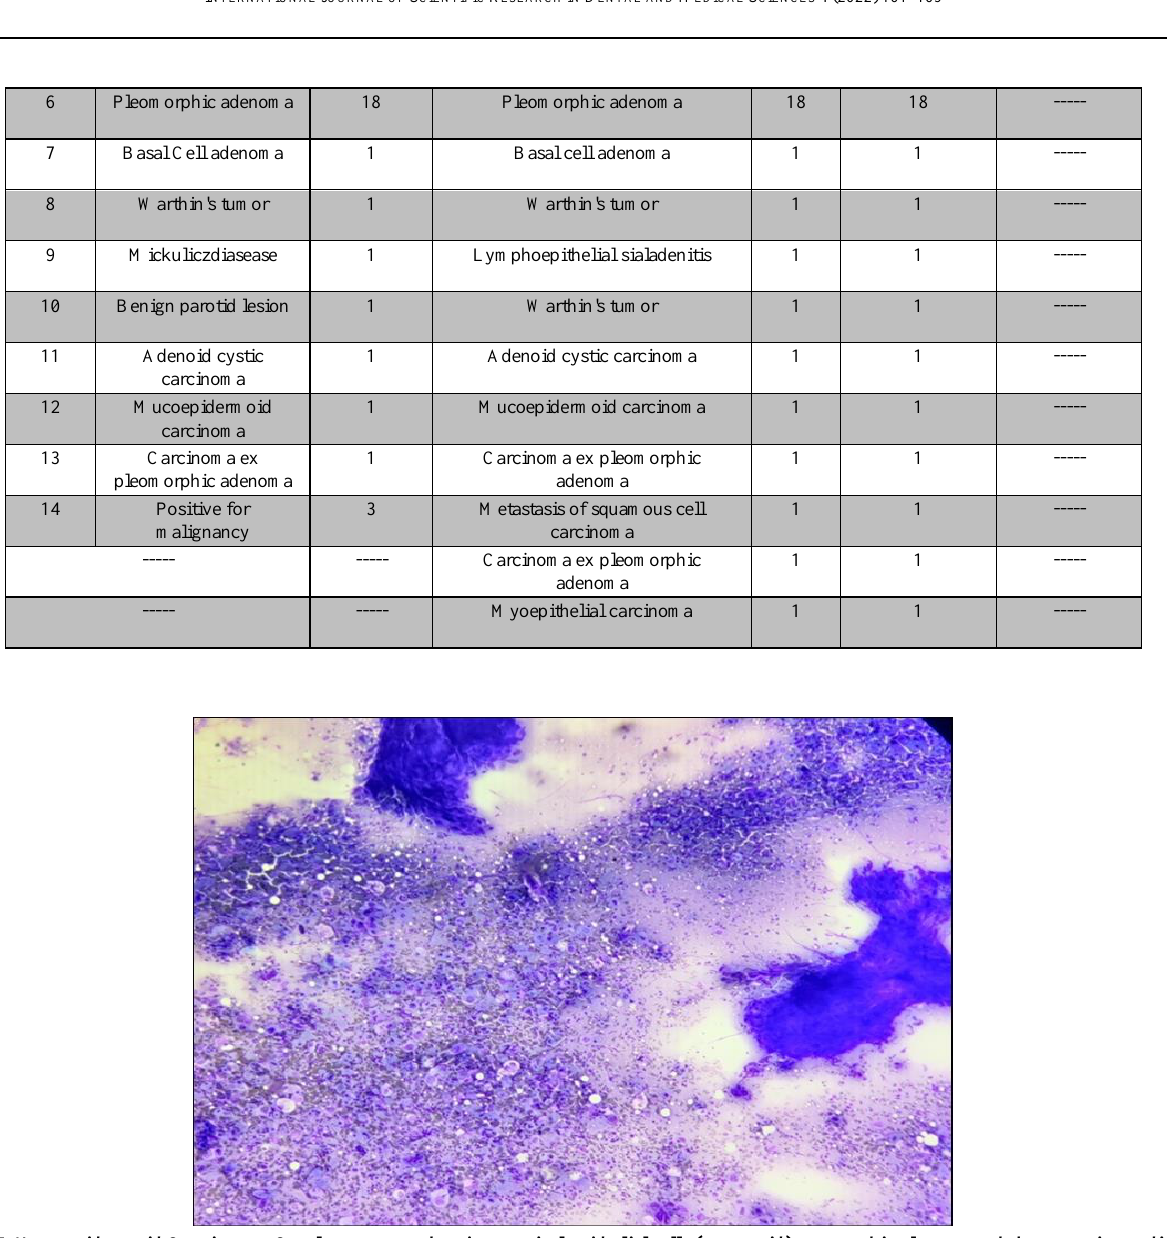
Fig. 5. Mucoepidermoid Carcinoma- Cytology smears showing atypical epithelial cells (squamoid) arranged in clusters and sheets against a dirty background of mucus and debris (Leishman,